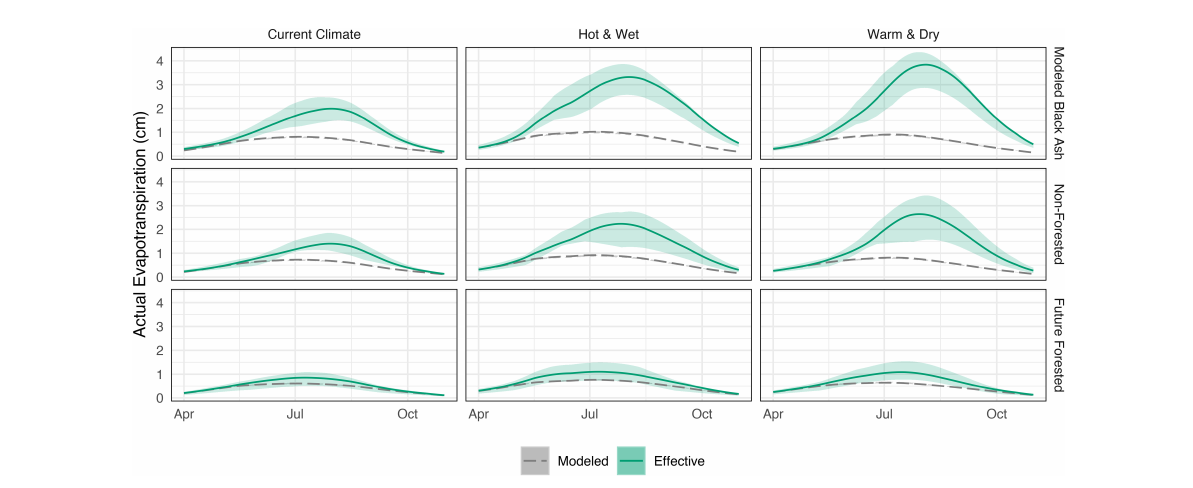
FIGURE9 Modeled and effective actual evapotranspiration under various climate scenarios and vegetation conditions. Modeled actual evapotranspiration (AET) is the synthetic potential evapotranspiration (PET) multiplied by the model coefficient used in the relevant wetland model. Effective AET is the modeled AET times the value of ecosystem specific yield (ESy) predicted from the contemporaneous water level, showing the magnitude of water level change. The difference between the two values demonstrates the two-stage impact of reduced ET, where AET and E Sy are reduced. Effective AET is shown in green with 67% HDCI as a shaded ribbon around the median line. Modeled AET is in gray, but has low variability around daily estimates masking the shaded gray